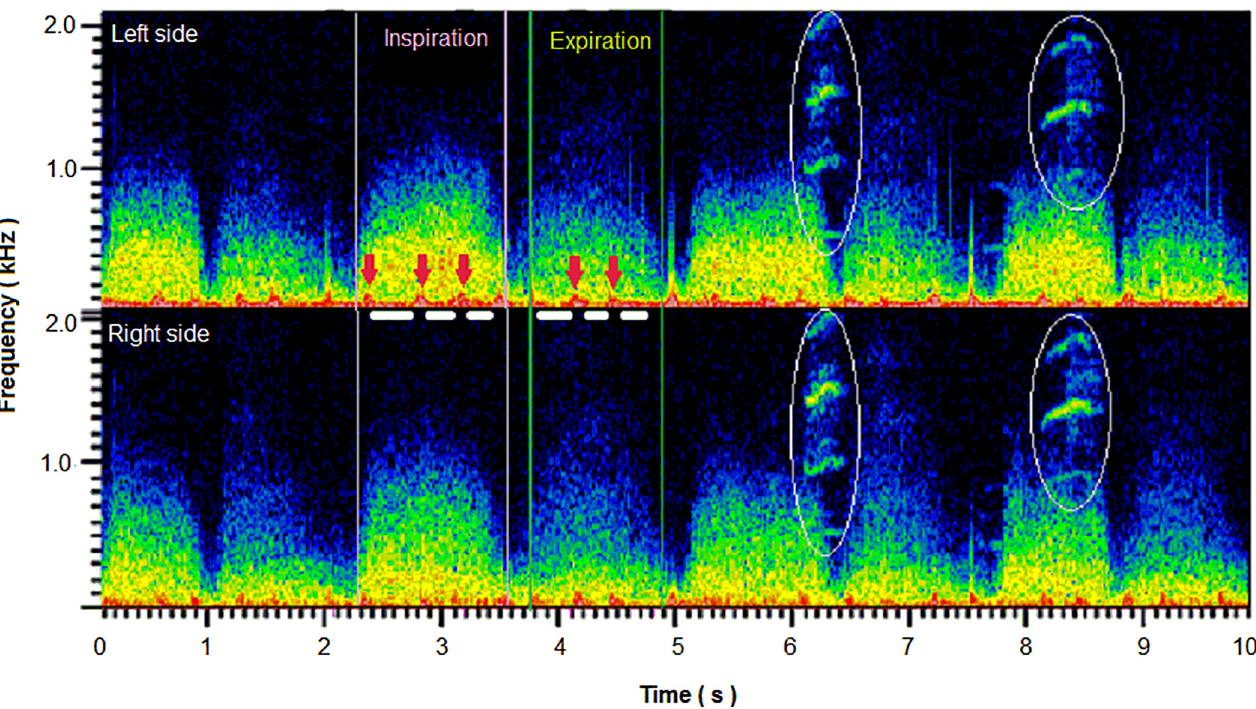
Fig 1. Example of the analytic procedure. Sound spectrographs were displayed on a monitor, and segments suitable for analysis were selected. The octave bands sound pressure levels were calculated as the averaged value for the segments (white horizontal bars) without noise contamination (heart sounds; red arrows). Spectra in the white ellipses indicate contaminated voice sounds of another child during one respiratory phase.